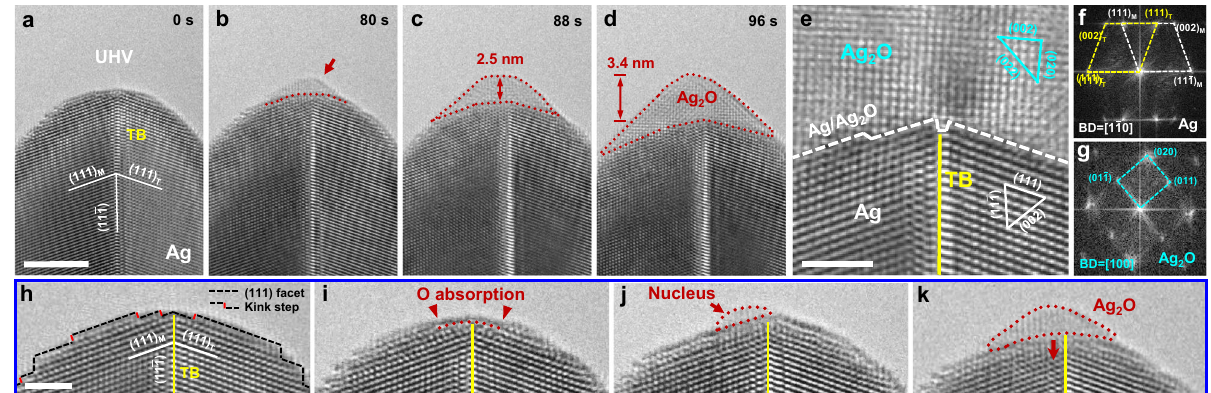
Fig. 1 Twin boundary-favoured oxidation of Ag nanocrystal. a Pristine Ag nanocrystal with a pre-existing twin boundary (TB) along the axial direction, which was placed in the ultrahigh vacuum (UHV) column of the transmission electron microscope (TEM). The nanocrystal has a clean surface with dominant (111) facets. b – d Dynamic snapshots showing the oxidation process of the Ag nanocrystal. The oxide embryo preferentially nucleated at the TB- surface junction ( b ), which grew continuously along the TB and expanded laterally on the nanocrystal surface ( c , d ). The red dotted loop delineates the oxidized region. e Zoomed-in image showing the atomistic structure of the as-formed Ag 2 O (top) and the Ag matrix (bottom). f , g Fast Fourier transform (FFT) patterns of the Ag nanocrystal with an axial TB and the oxidation product of Ag 2 O, respectively. h – k Atomistic nucleation and growth of oxide at the surface – TB junction. h Clean surface of the nanocrystal with alternate (111) atomic facets and kink steps, where a higher density of kink steps pre-exist near the TB. i Preferential surface adsorption of oxygen at the TB tip, as indicated by the red dotted curve. j A tiny oxide nucleus formed at the TB-surface junction. k Continuous growth of Ag 2 O along the TB, as shown by the red arrow. Scale bars in a 5 nm; e , h 2